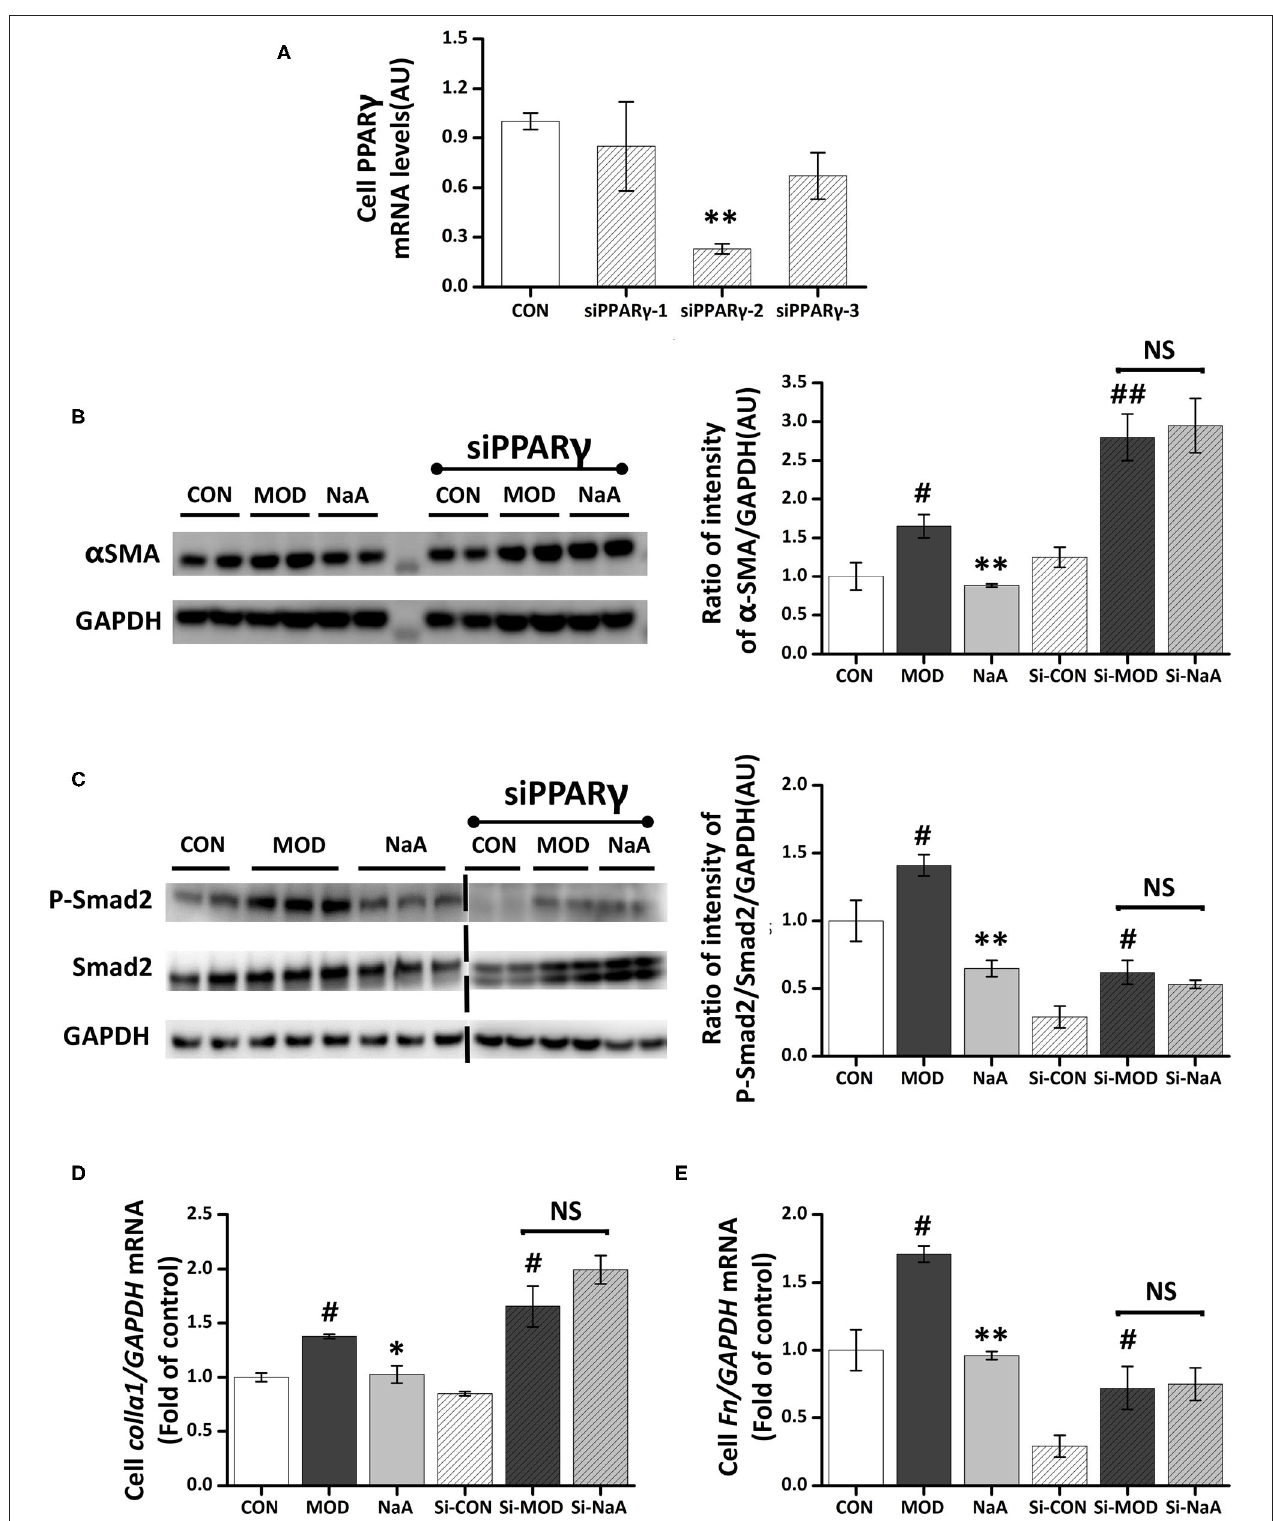
FIGURE 6 | NaA-mediated anti-fibrosis effects were partially reversed by siRNA-PPAR γ . LX2 cells were cultured and transfected with 50nM Lipofectamine ® 2000 RNAiMax reagent and PPAR γ siRNA. (A) Real-time PCR was used to evaluate the mRNA expression of PPAR γ , selected the sequences with the best